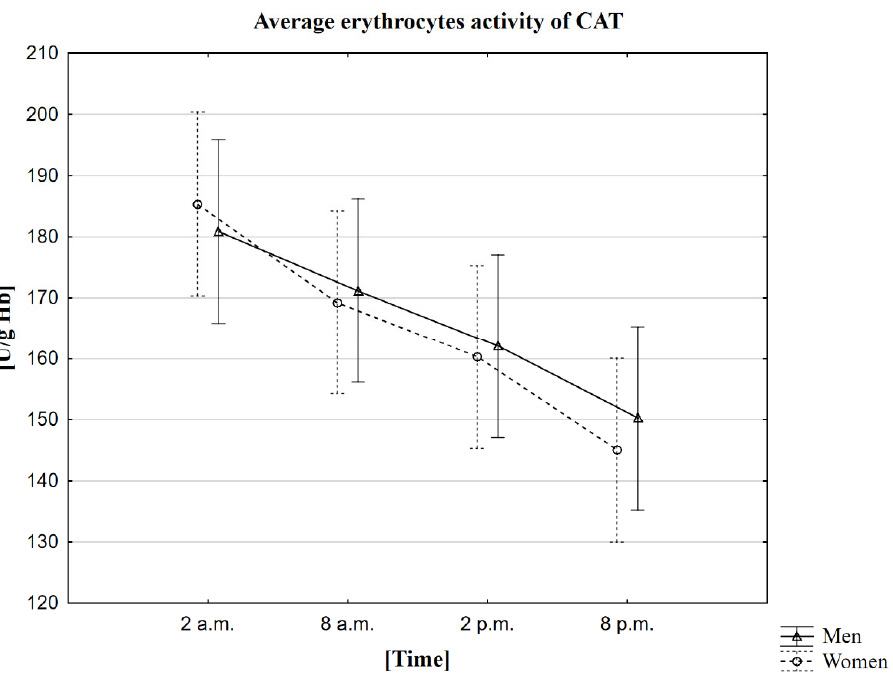
Table 4. Parameters describing the activity of catalase (CAT) in women and men including the time of blood collection (U/g Hb).